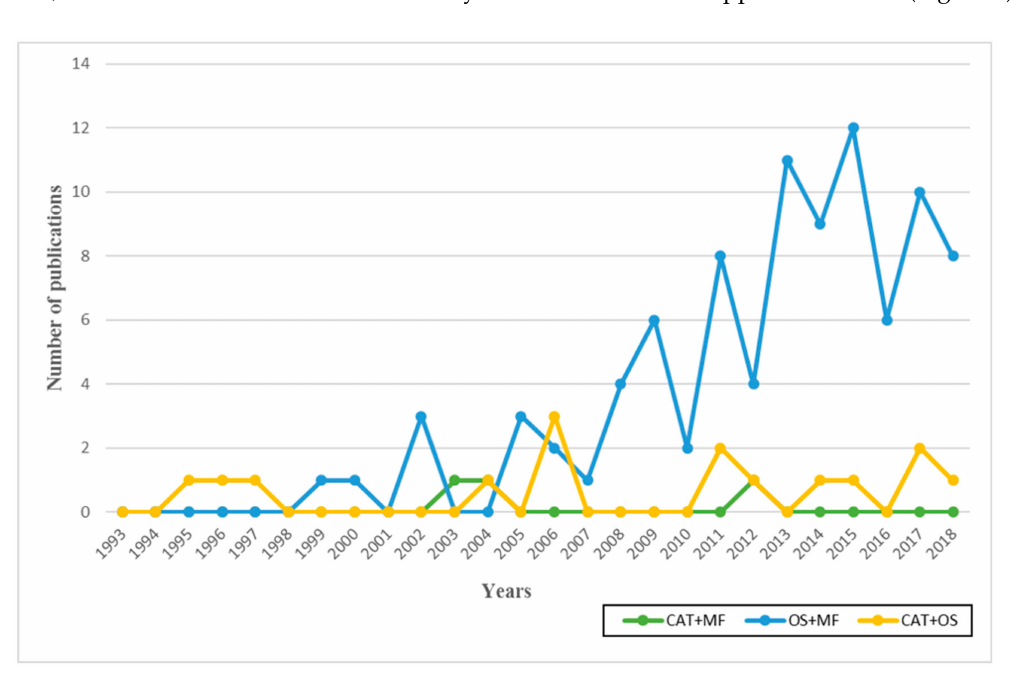
Figure 1. Number of publications per year (January 1993–December 2018) and by keyword. Database created after applying the inclusion and exclusion